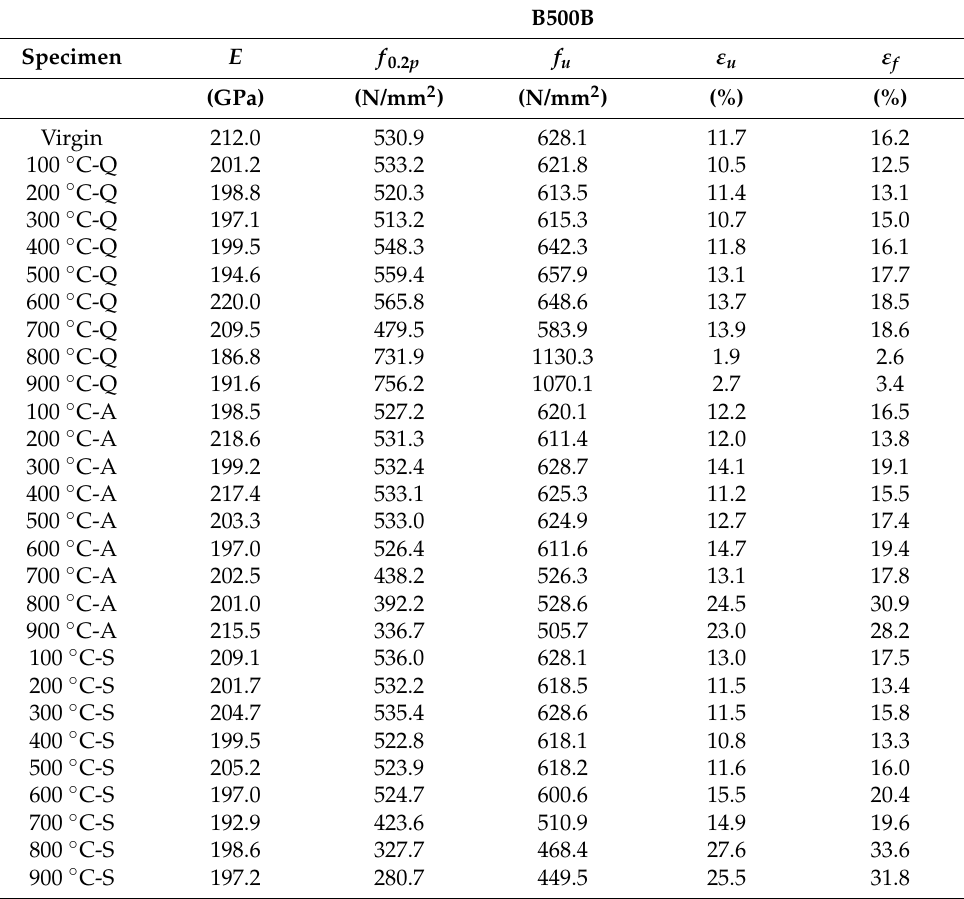
Table 6. Post-fire properties of carbon steel grade B500B reinforcing